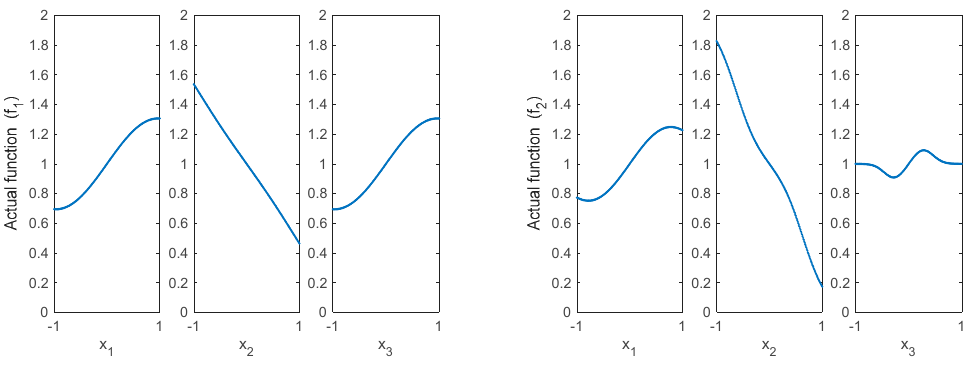
Figure 5. Actual main effects plot for 𝑓 (cid:2869) and 𝑓 (cid:2870) .